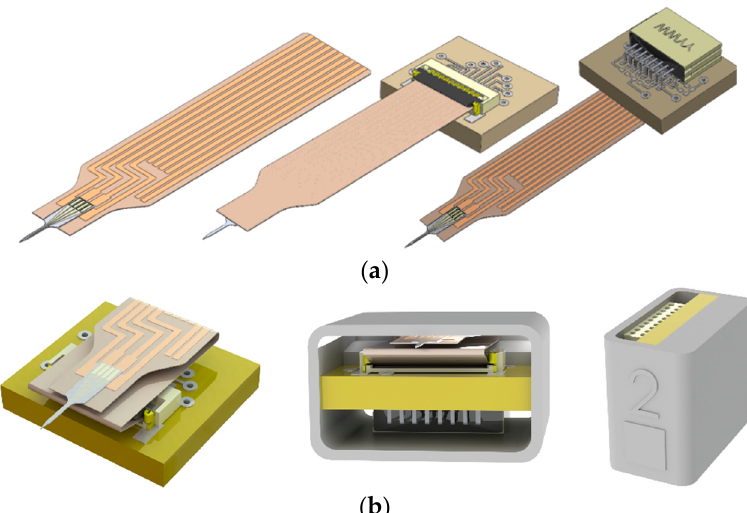
Figure 3. Packaging scheme for PVAc-CNC intracortical probes. ( a ) The probes are attached to a polyimide-based ribbon cable with patterned Cu traces. The ribbon cable is designed for insertion into a flexible circuit connector mounted on a printed circuit board with an Omnetics connector for interfacing with external electronics; ( b ) The ribbon cable/PCB/connector assembly is inserted into a custom-designed, 3D-printed housing to protect the components.